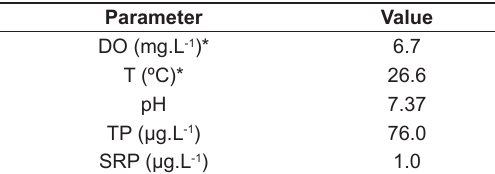
Table 1. Water quality parameters of the water overlaying the sediment from Lake